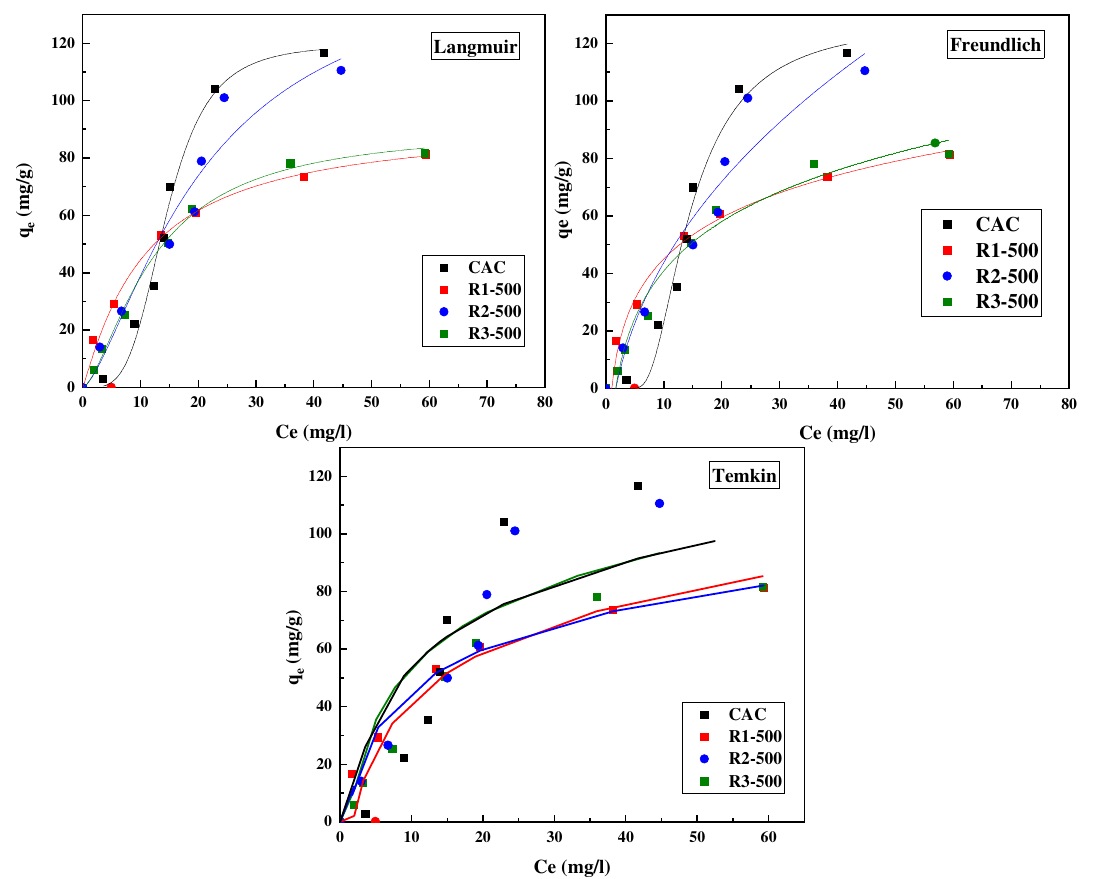
Figure 3. Adsorption isotherms of atenolol on the different activated carbons at 25 °C (symbols: experimental values; continuous lines: fitting to Langmuir, Freundlich and Temkin equations).